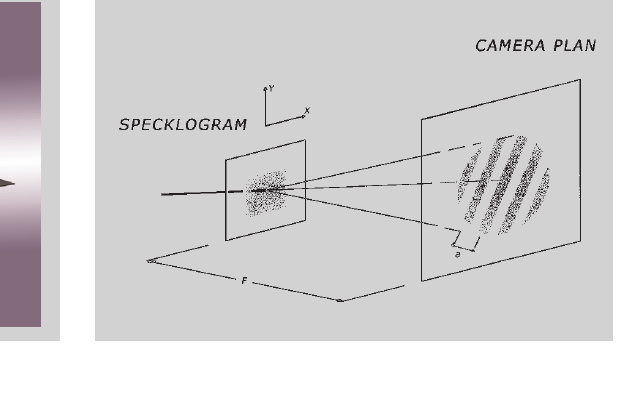
Figure 1a (left): Experimental set-up for specklegram registration. Figure 1b (right): Schematic presentation of the velocity vectors measurement by